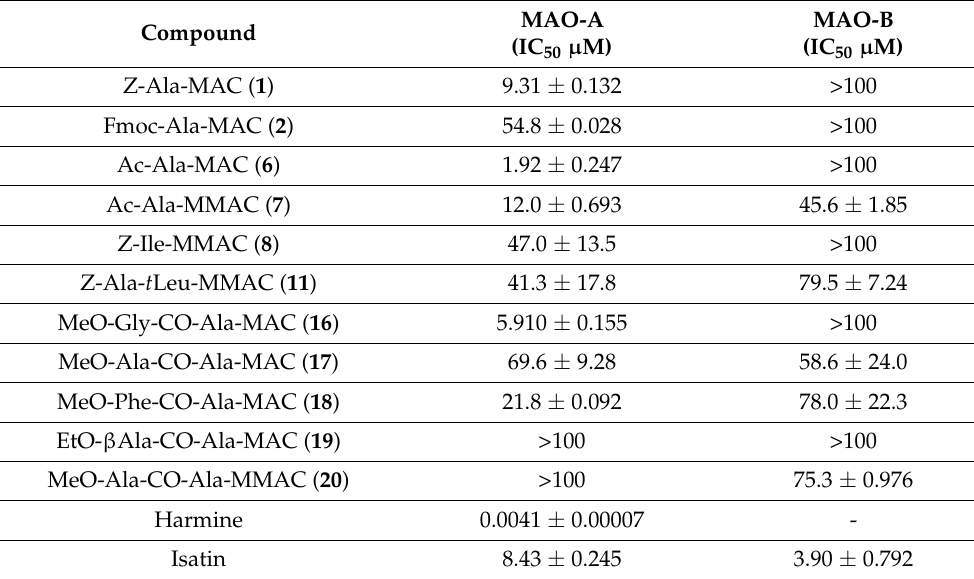
Table 2. Inhibitory activities reported as IC 50 µ M values a of amino acyl (compounds 1 , 2 , 6 – 8 ) and ( pseudo )-dipeptidyl coumarins 11 , 16 – 20 against hMAO-A and hMAO-B.